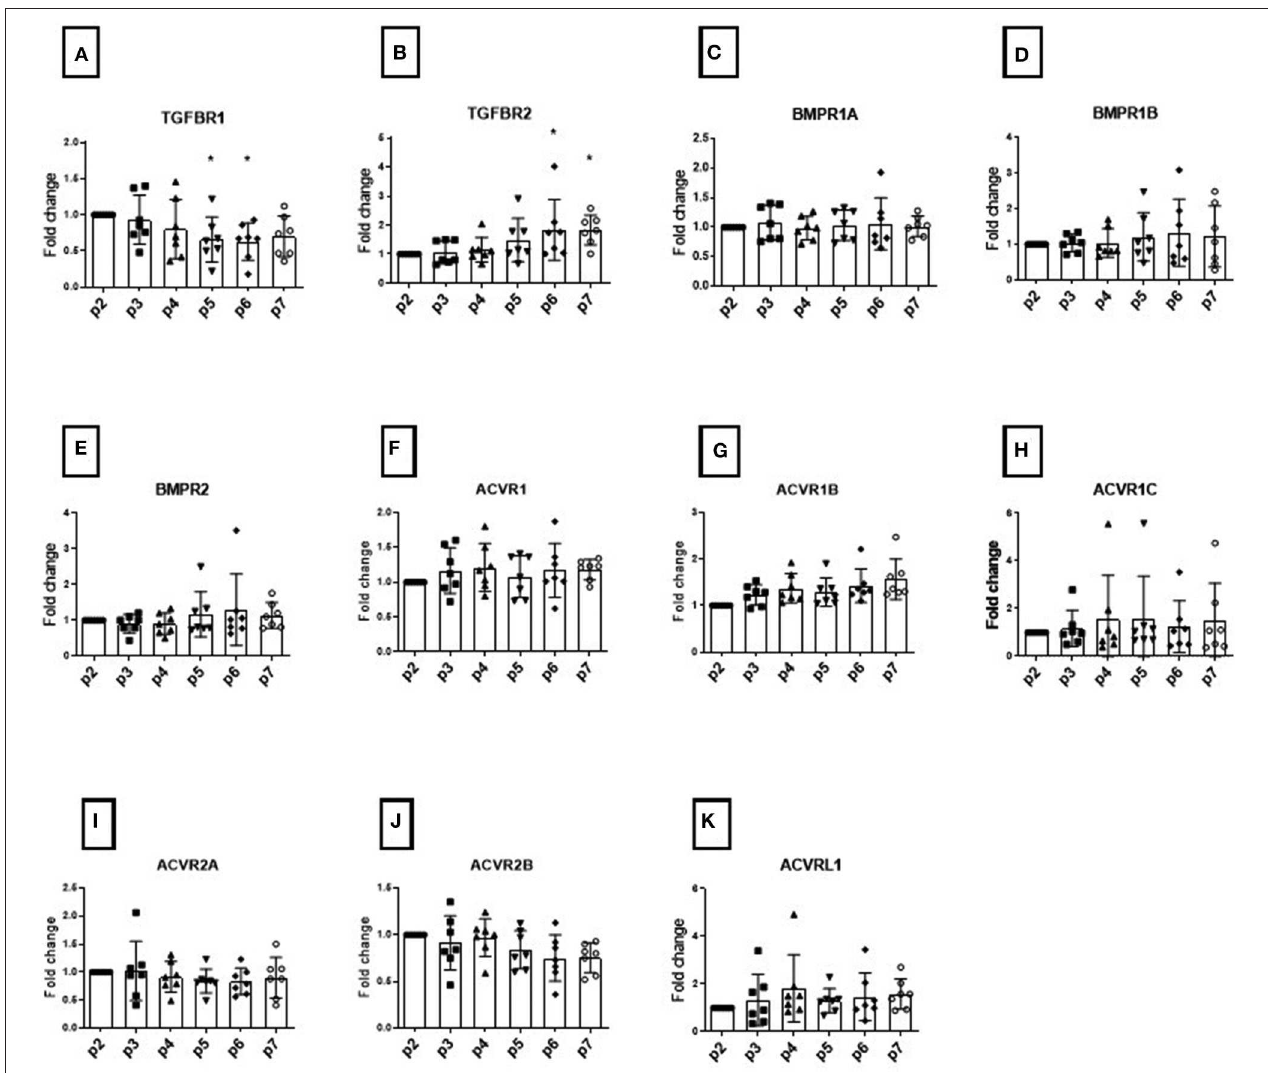
FIGURE 1 | Modulation of TGFB receptors during monolayer expansion of hBMSCs from passage 2 to passage 7. Cells from different donors were cultured in conventional expansion medium. The amounts of TGFBR1 (A) , TGFBR2 (B) , BMPR1A (C) , BMPR1B (D) , BMPR2 (E) , ACVR1 (F) , ACVR2B (G) , ACVR1C (H) , ACVR2A (I) , ACVR2B (J) , ACVRL1 (K) mRNA was normalized to ribosomal protein large, P0 (RPLP0). The mRNA expression of cells cultured over the passaging were plotted as 2 ( − 11 Ct ) (mean ± SD ; n = 7) as a fold change to the BMSC in passage 2, the dots shows the different donors, * p < 0.05 compared to